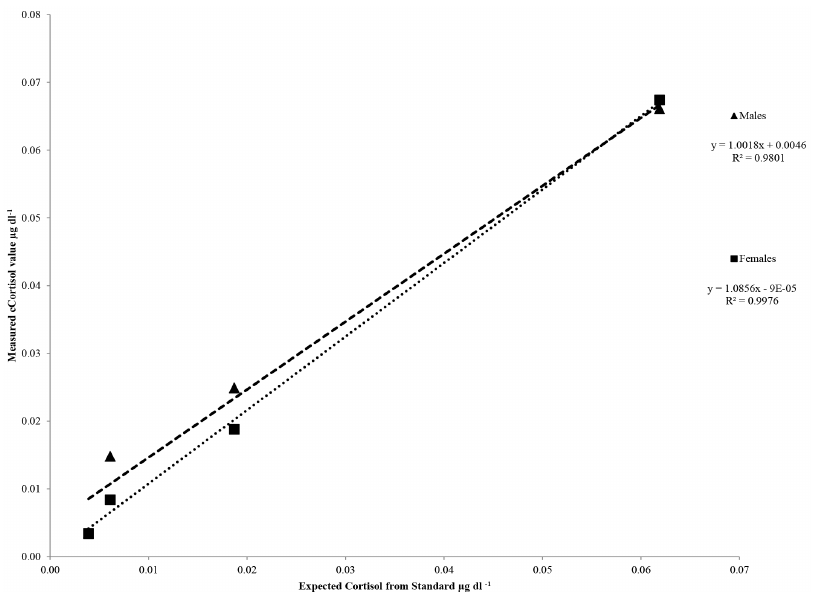
Figure 6. Results of accuracy testing for the Cayman kit using pooled male (blue diamond) and female (red square) blow samples. Measured cortisol values are calculated with the actual sample cortisol subtracted and compared against the known standard